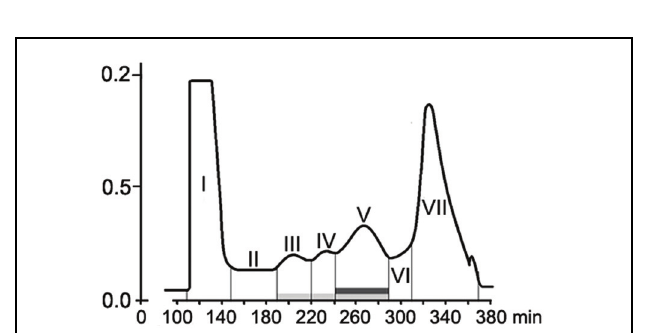
FIGURE 2 | Histograms showing the lack of direct toxic impact of high-molecular weight metabolites (HMWM) from F. oxysporum CS-20 toward pathogenic F. oxysporum f. sp. lycopersici strains (F37 and Fot3). Mean values of three independent experiments, each of them comprised in vitro growth (A) and spore germination (B) tests, are presented. Bars represent SD.